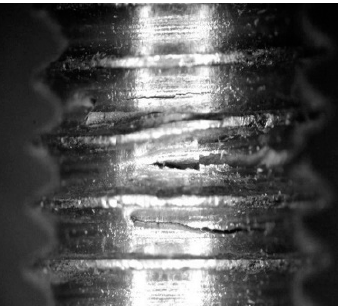
13 of 19 Figure 13. Fracture surface produced by different clamp lengths at high, medium and low loads. ( a ) levers of ( a/b ) 19/17 mm ( b ) levers of ( a/b ) 29/17 mm ( c ) levers of ( a/b ) 39/17 mm ( d ) levers of ( a/b ) 44/17 mm. The observation of the thread’s lateral surface shows that, as a general rule, the fa- tigue crack is located in only one thread root. Nevertheless, additional cracks grown from the adjacent roots are observed in failures produced using the longer clamps (see Figure 14). This effect can be attributed to a less homogeneous load transfer at the bolt head when